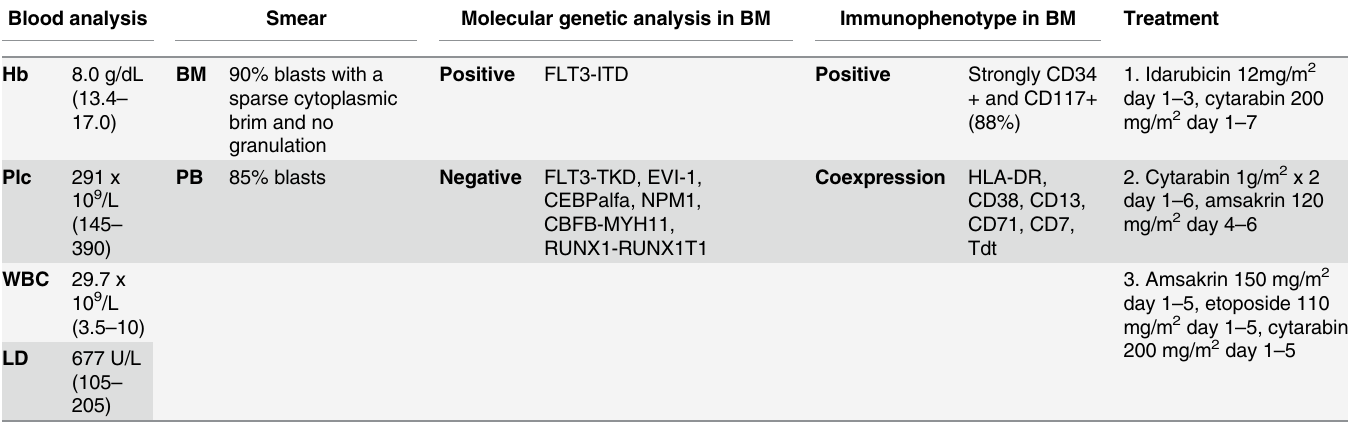
Table 1. Hematological data and treatment on the AML patient with the t(2;14) chromosomal aberration. Blood analysis